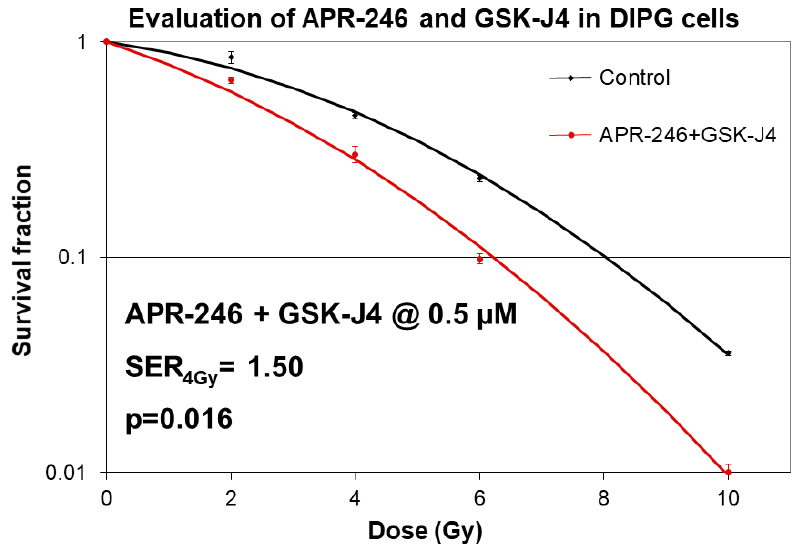
Figure 5. Radio-sensitizing effects of APR-246 combined with GSK-J4 in clonogenic survival assays in H3K27M DIPG cells. Clonogenic survival assays with SF8628 pediatric DIPG cell line harboring the histone H3.3 K27M mutation. DIPG cells were pre-treated for 5 days with 0.5 µM concentration of GSK-J4 and APR-246 before plating and radiation treatments (0–10 Gy doses). Survival fractions were determined 2 weeks after plating. Curve fitting was performed using linear quadratic equation. Sensitizer enhancement rations (SERs) were calculated for the dose 4 Gy. Mean SERs from two independent experiments with 3 data points per experiment are shown followed by SER 4Gy = sensitizer enhancement ratio at 4 Gy radiation dose.